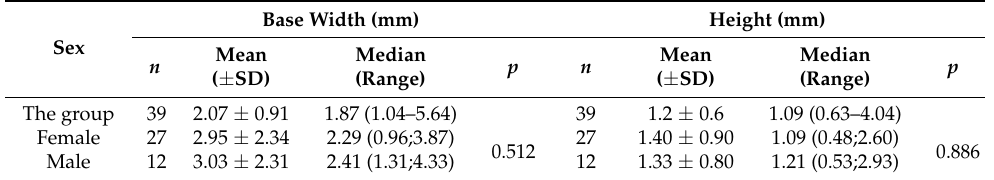
Table 1. Cyst size measured with ultrasound biomicroscopy in 39 patients depending on sex.